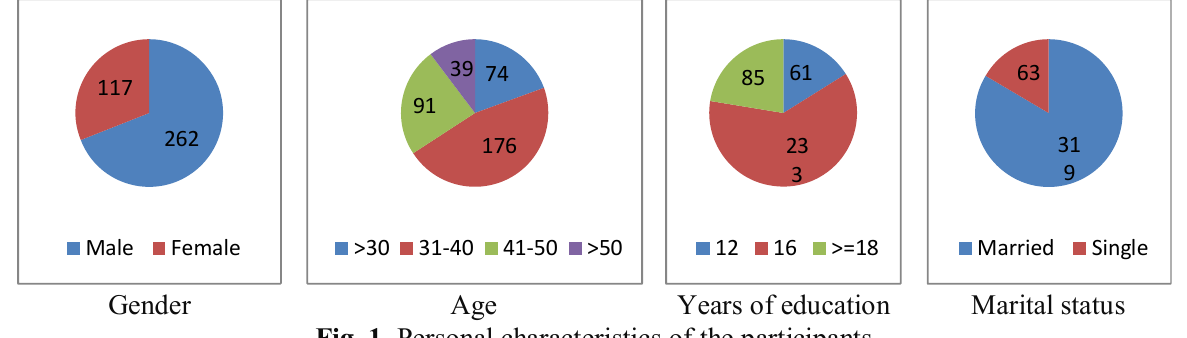
Fig. 1. Personal characteristics of the participants